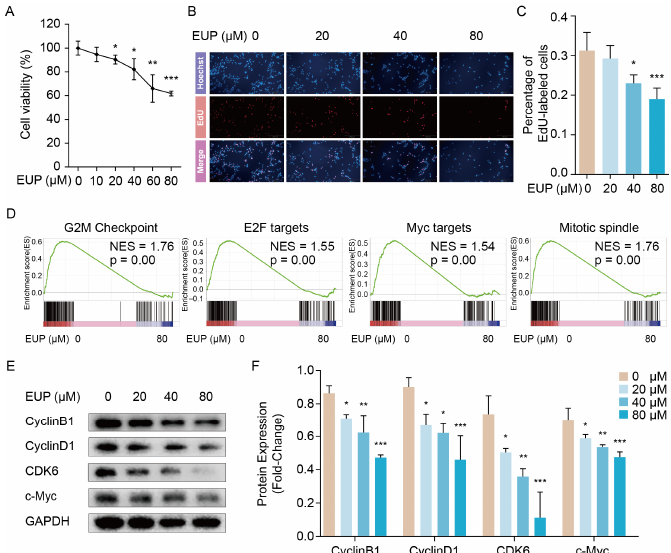
Figure 2. Eupatilin inhibits the proliferation of LX-2 cells. ( A ) Cell viability of LX-2 cells treated with different eupatilin concentrations. ( B ) The effect of eupatilin on DNA replication of LX-2 cells inves- tigated by EdU staining. ( C ) The percentage of EdU-labelled cells is plotted (mean ± SD, n = 4). ( D ) GSEA enrichment plots showed four proliferation-related gene sets were down-regulated in eu- patilin exposed LX-2 cells. ( E ) The protein levels of CyclinB1, CyclinD1, CDK6, and c-Myc detected 48 h after eupatilin treatment using Western blotting. ( F ) Relative protein signal intensity was quan- tified as mean ± standard deviation (mean ± SD, n = 3). p values are calculated by one-way ANOVA followed by the Tukey’s test. * p < 0.05, ** p < 0.01 and *** p < 0.001 vs. 0 μ M EUP group. EUP: Eupatilin; GSEA: Gene set enrichment analysis; CDK6: Cyclin dependent kinase 6; GAPDH: Glycer- aldehyde-3-phosphate dehydrogenase.